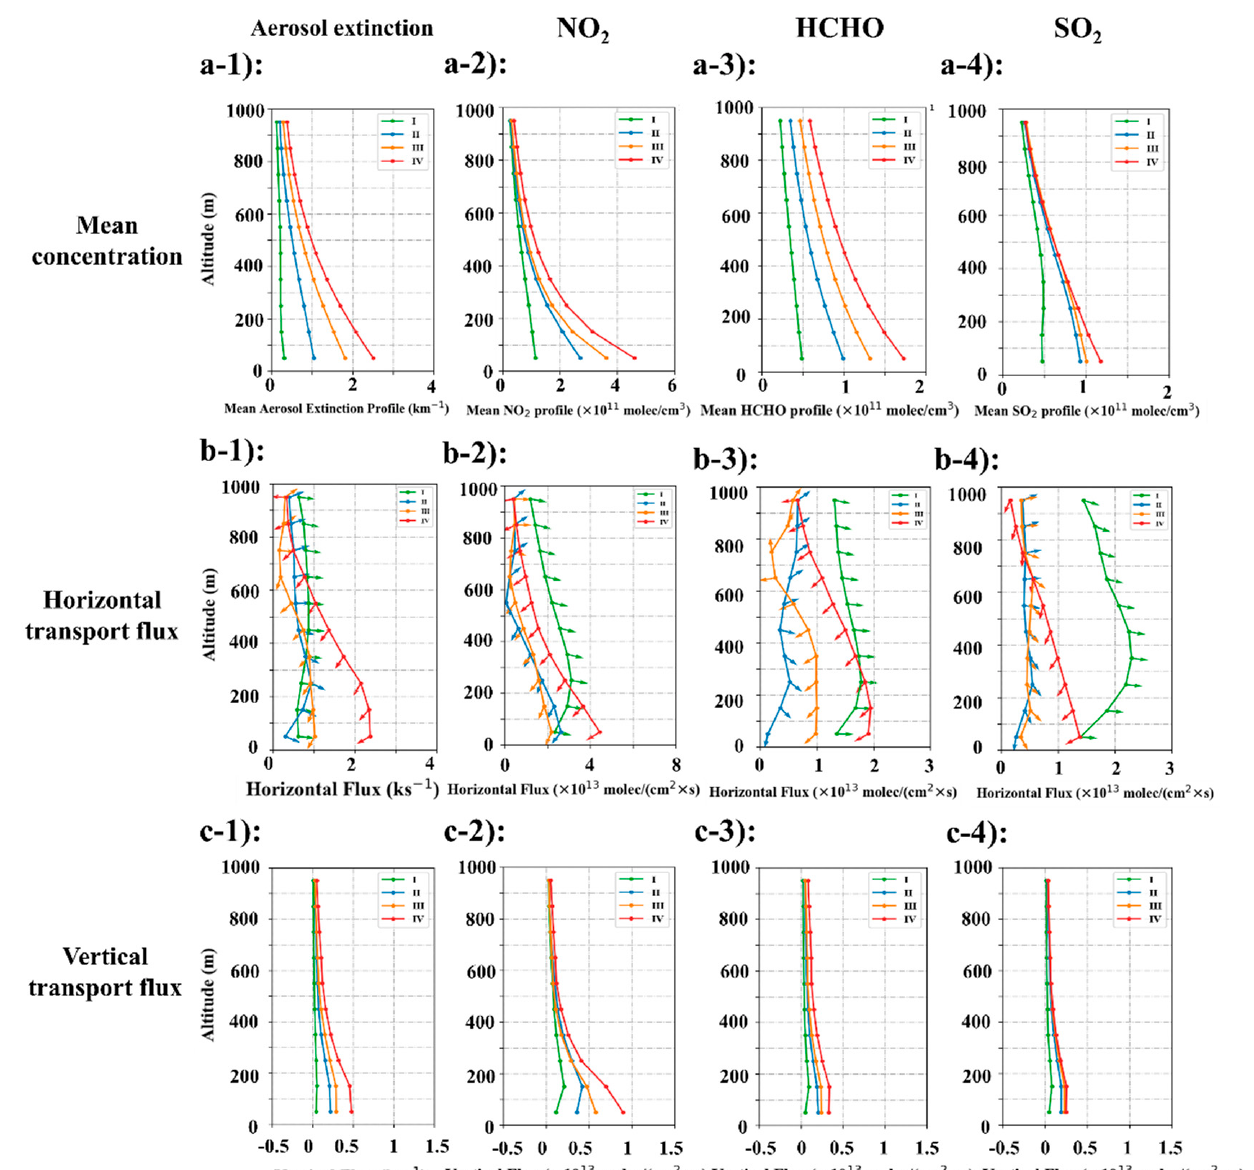
Figure 8. Mean concentration profiles: horizontal and vertical transport flux profiles for aerosol extinction, NO 2 , HCHO and SO 2 under different degrees of pollution ( a ) for concentration, ( b ) for horizontal transport profiles (arrows represent the average direction with respect to the north) and ( c ) for vertical transport flux profiles (positive means upwelling, negative means downwelling) (PM 2.5 concentrations: period I (<35 ug/m 3 ), period II (35–75 ug/m 3 ), period III (75–115 ug/m 3 ) and period IV (>115 ug/m 3 )).